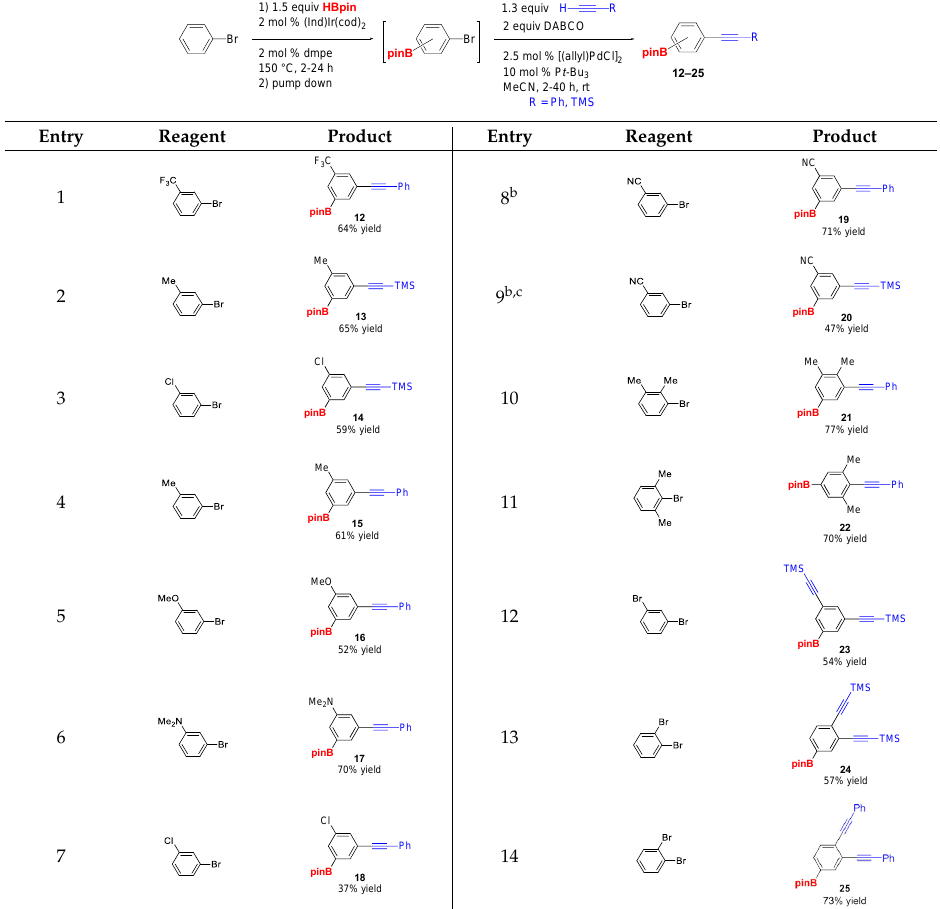
Molecules 2019 , 24 , x